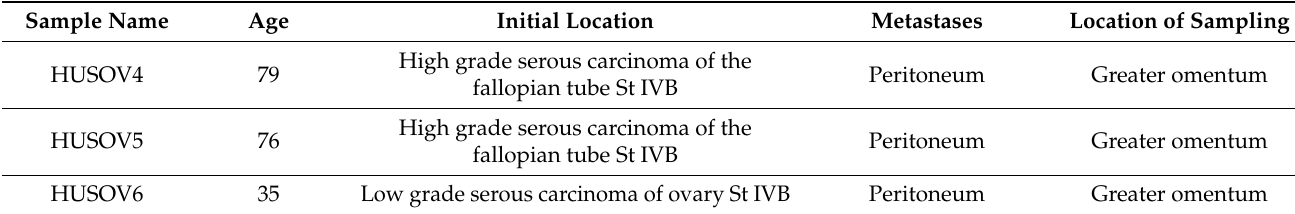
Table 1. Patient sample